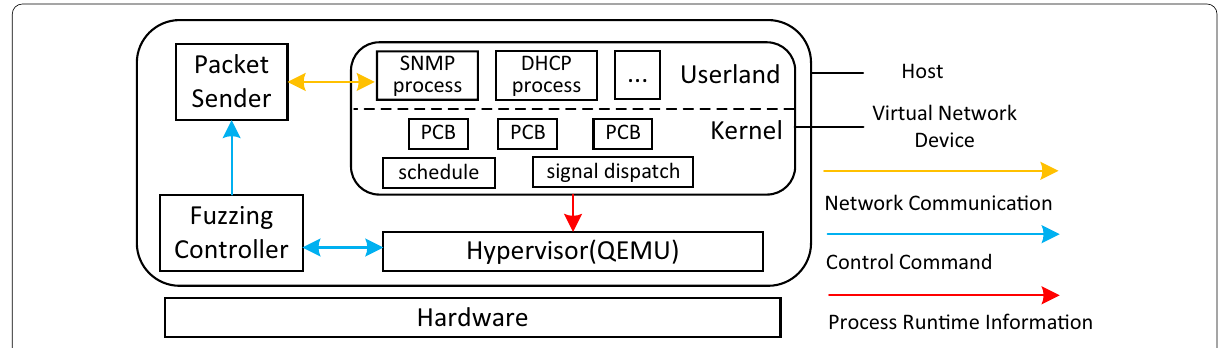
Fig. 1 Typical procedure to fuzz a network